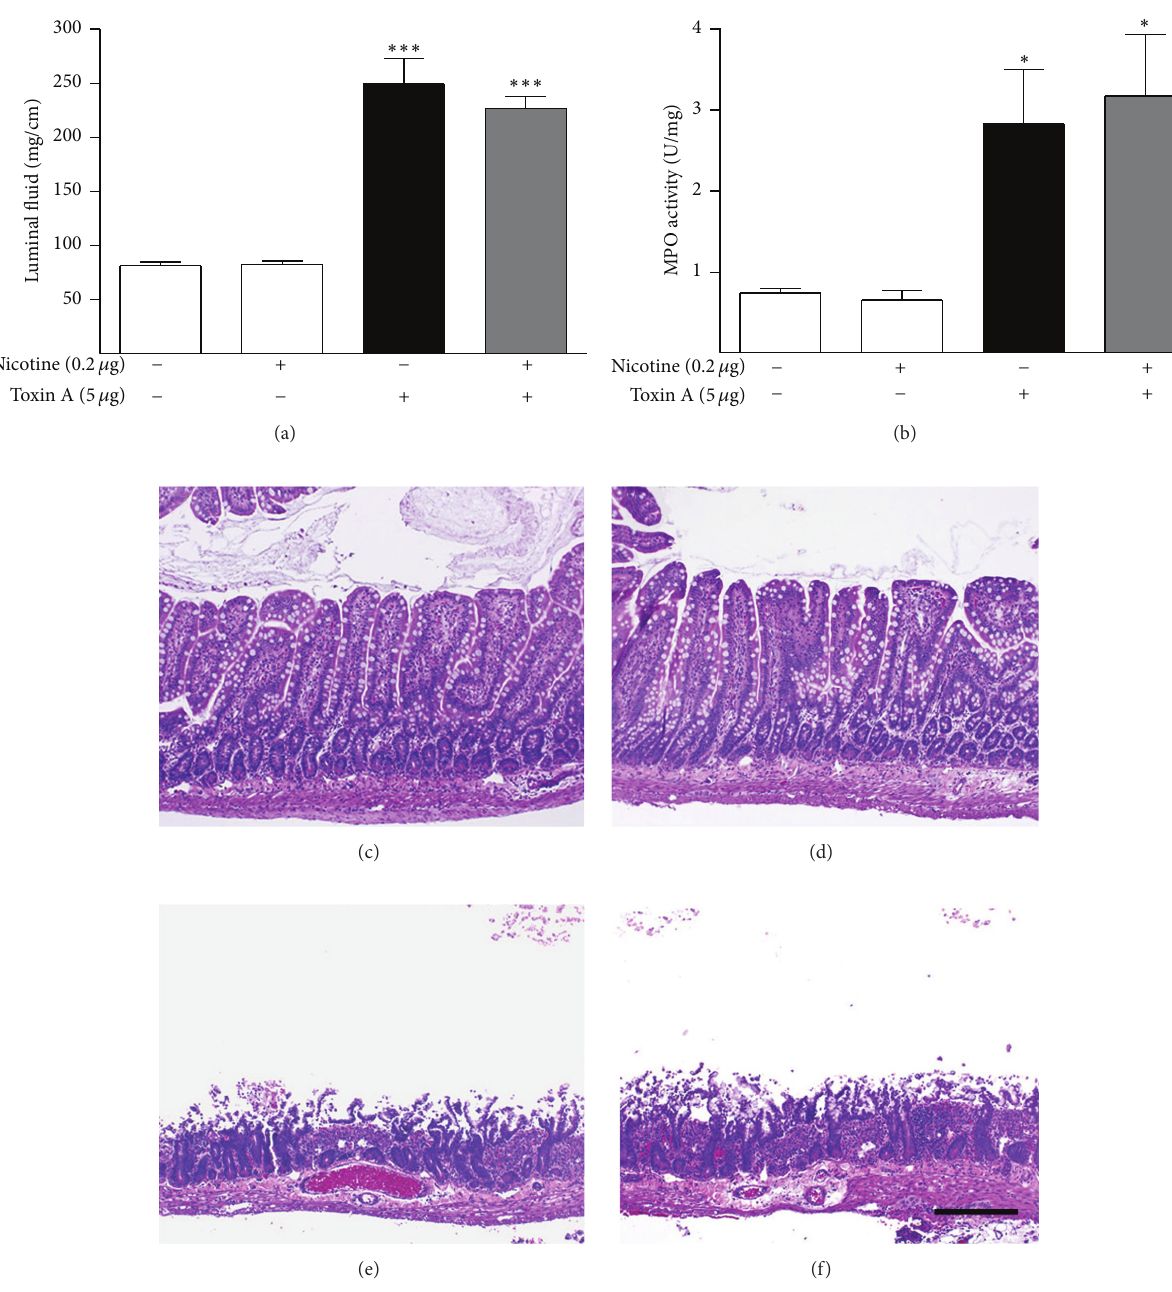
Figure 2: Lack of effect of nicotine on toxin A-induced luminal fluid accumulation (a), MPO content (b), and histopathology in the ileum (c–f). Nicotine pretreatment had no effect on toxin A-stimulated ileal luminal fluid accumulation (a) or MPO content (b). ∗ 𝑃 < 0.05 versus control; ∗∗∗ 𝑃 < 0.001 versus control; 𝑁 = 6 . (c) Control section illustrating the normal histology of the rat ileum. (d) Nicotine (0.2 𝜇 g) alone had no effect on ileal histology. (e) Toxin A (5 𝜇 g) caused extensive inflammatory damage to the ileum including complete loss of villi, crypt distortion, surface ulceration, and influx of neutrophils. (f) Toxin A (5 𝜇 g) after pretreatment with 0.2 𝜇 g nicotine. This dose of nicotine was maximally effective against toxin A in the colon but did not protect the ileum. Line bar = 100 𝜇